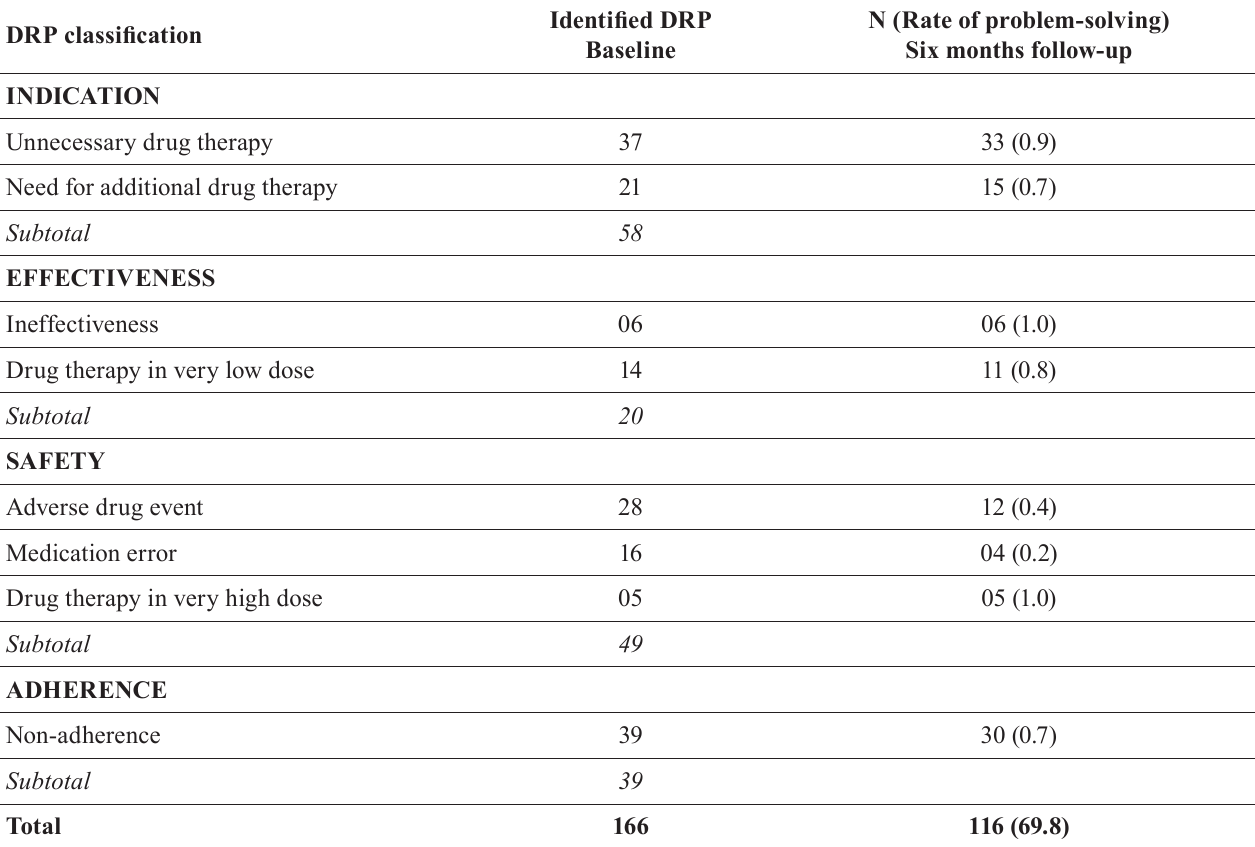
TABLE III - Description of Drug Related problem (DRP), according to nature, the adopted strategy and rate of problem-solving by Medication Therapy Management, Araraquara